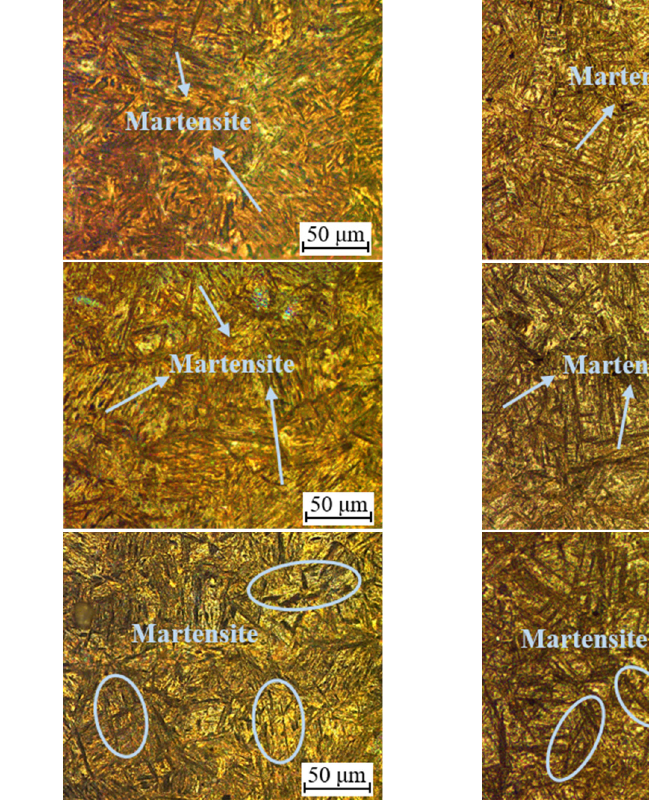
Figure 14. Metallography microstructures of different temperature measuring points.